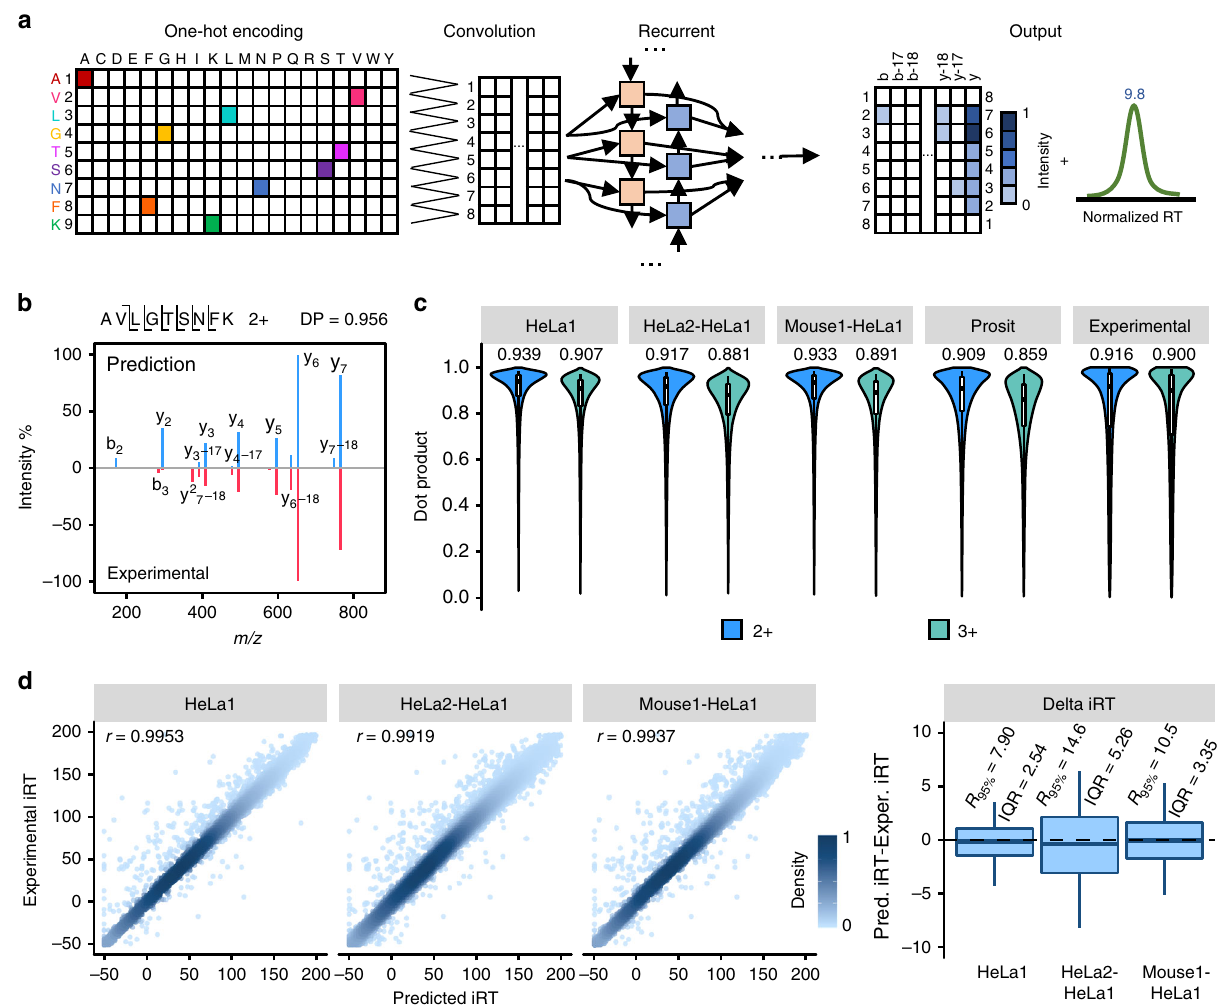
Fig. 2 Peptide MS/MS spectrum and iRT prediction. a A graphical illustration of the deep neural networks for peptide MS/MS spectrum and iRT prediction. b A representative spectral match of a peptide (AVLGTSNFK 2 + ) between its higher energy collisional dissociation (HCD) MS/MS spectrum and the corresponding in silico predicted MS/MS spectrum. c The distributions of dot products computed between predicted and experimental b/y/neutral loss peak intensities. The medians are indicated. The boxes and whiskers show the quantiles and 95% percentiles, respectively. d Pearson correlation coef fi cients ( r ) and the differences computed between predicted and experimental normalized retention time (iRT). Color gradation indicates relative density of data points. The boxes show interquartile ranges (IQR), and the whiskers show 95% percentiles; no outliers are shown. 2 + : doubly charged precursors; 3 + : triply charged precursors. Source data are provided as a Source Data fi